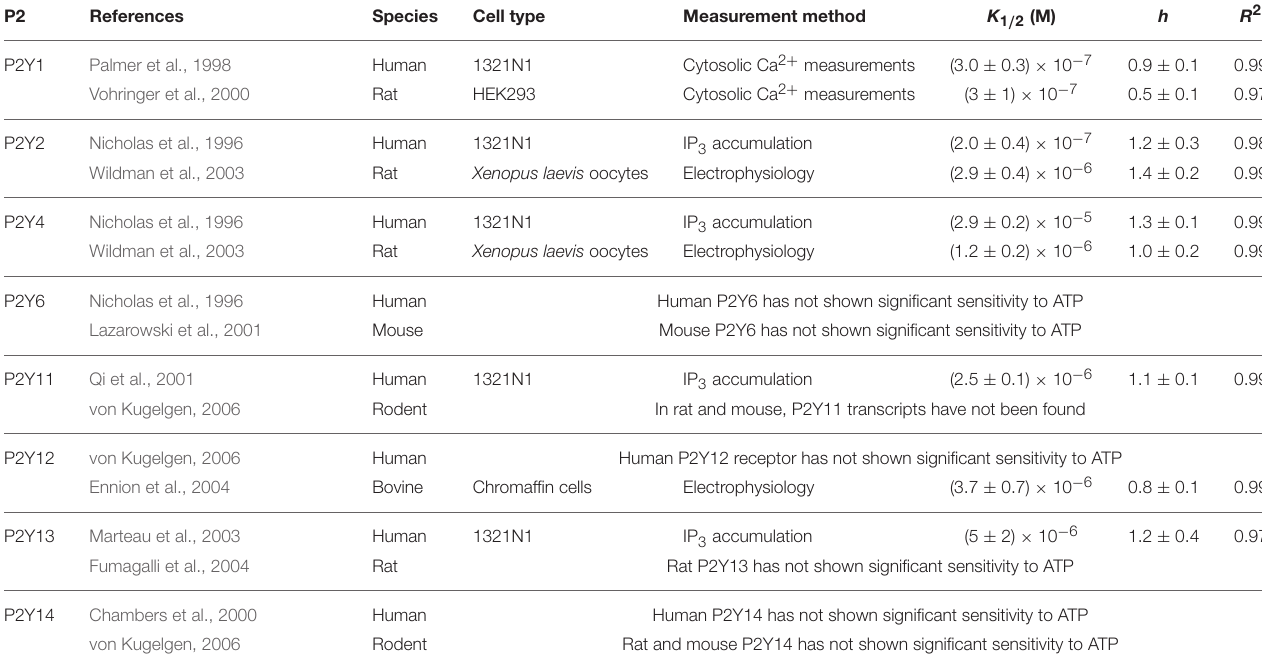
TABLE 2 | P2Y Receptors: data sources and fitting parameters.